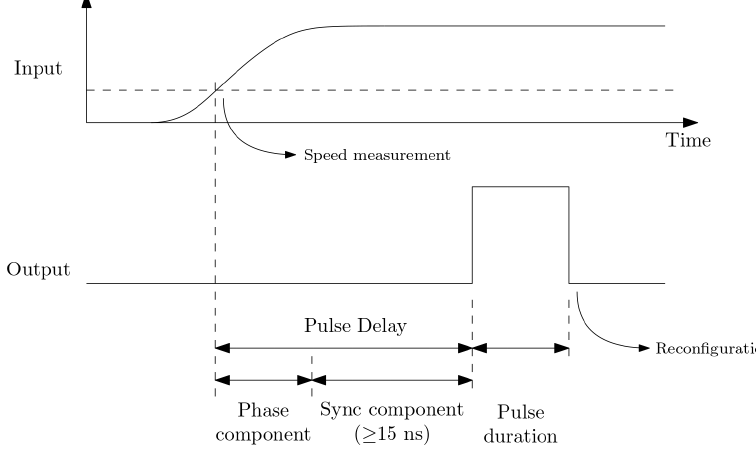
Figure 5. Components and timing of the output